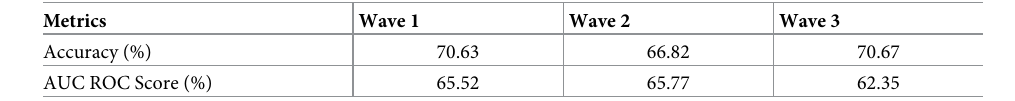
Results were obtained after a 5-fold cross-validation process, including an inner cross-validation for hyperparameter optimization.